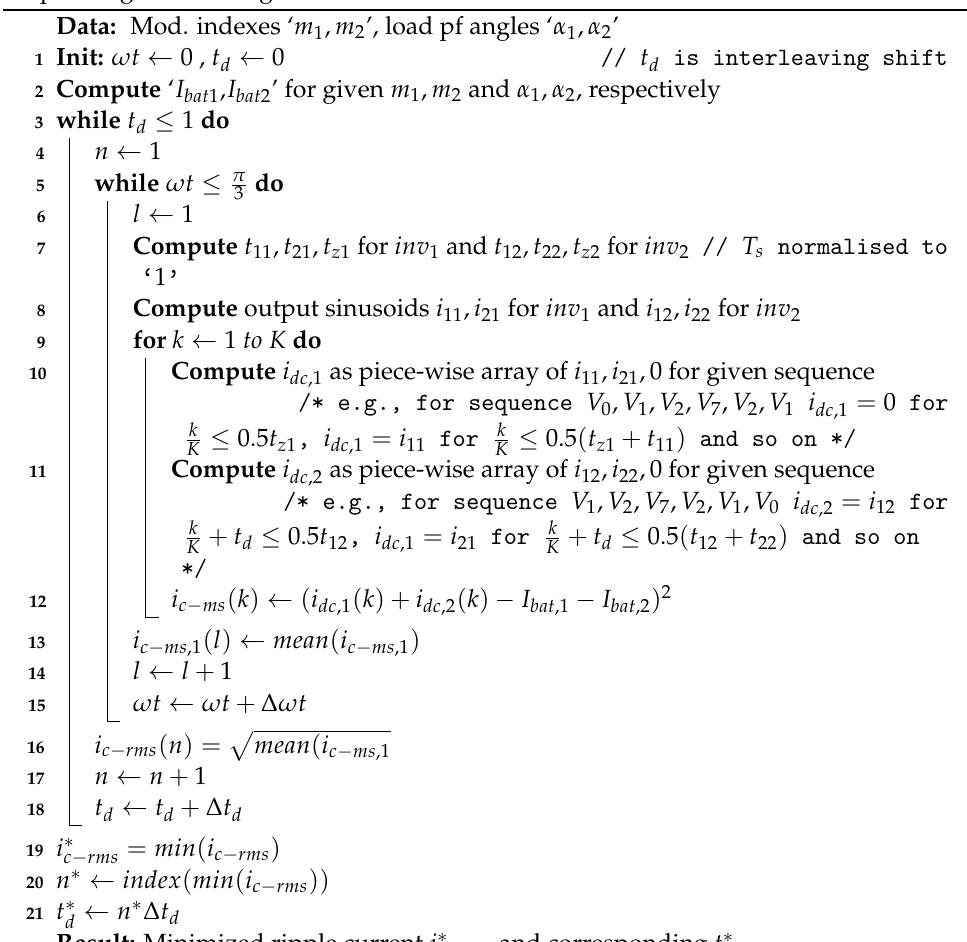
Algorithm 1: Linear search algorithm for the min. cap ripple current and corre- sponding interleaving